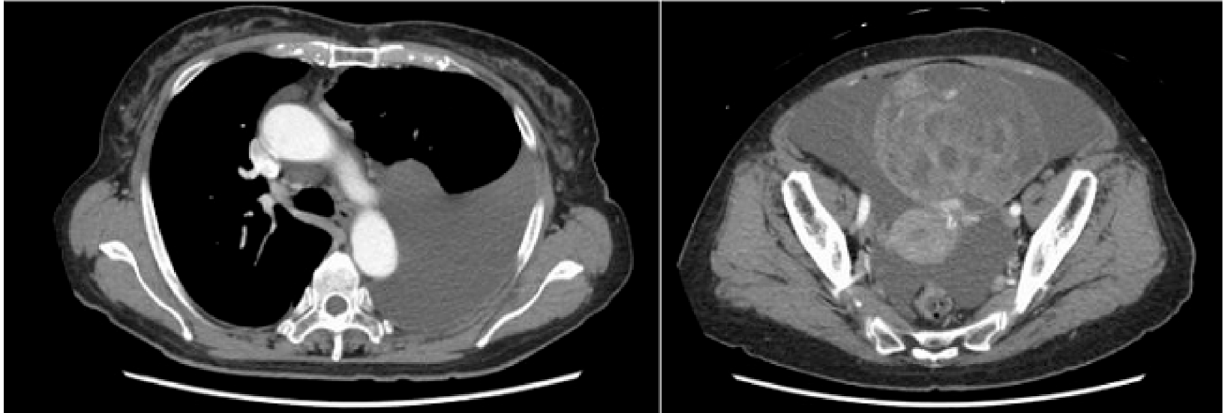
Figure 1. Retention of pleural and ascitic fluid was observed.